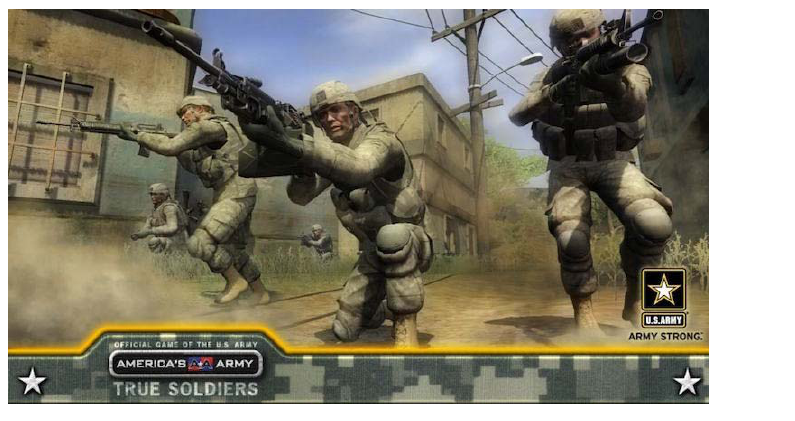
Figure 7 – Acivities in military simulation systems (America’s Army, 2010) Рис . 7 – Активности в рамках военного моделирования (America’s Army, 2010) Слика 7 – Активности у оквиру система војне симулације (America’s Army,